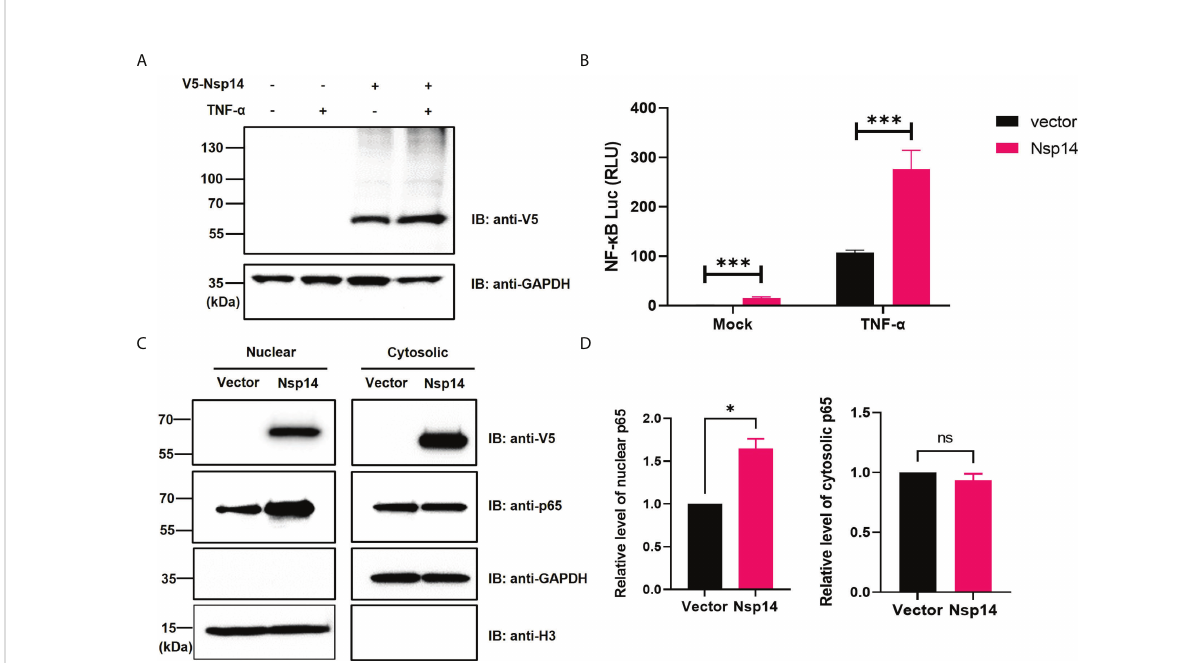
FIGURE 1 SARS-CoV-2 Nsp14 increases NF- k B activity. (A – C) HEK293T cells were transiently transfected with V5-FLAG-Nsp14 or empty vector for 24h and then treated with or without TNF- a for 24h. V5-FLAG-Nsp14 was analyzed by protein immunoblotting (A) . HEK293T cells transfected with V5- FLAG-Nsp14 or empty vector along with NF- k B-driven fi re fl y luciferase and TK-driven renilla luciferase reporter vectors were un-treated or treated with TNF- a (B) . Luciferase activity ( fi re fl y/renilla) in these cells was measured and normalized to the untreated group with the empty vector. HEK293T cells transfected with V5-FLAG-Nsp14 or empty vector were subjected to the nuclear/cytosolic fractionation. V5-FLAG-Nsp14 and NF- k B p65 in the nucleus or cytosol were analyzed by protein immunoblotting (C) . Histone H3 was used as the nuclear marker. The intensity of the p65 protein band was quanti fi ed and normalized to the empty vector (D) . Results were calculated from 3 independent experiments and presented as mean +/- standard error of the mean (SEM). (ns: not signi fi cant ; * p<0.05; *** p<0.001; by unpaired Student ’ s